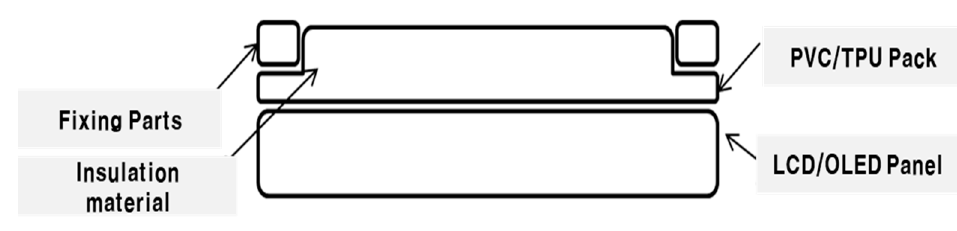
Figure 3. Touch panel of DiverPAD.